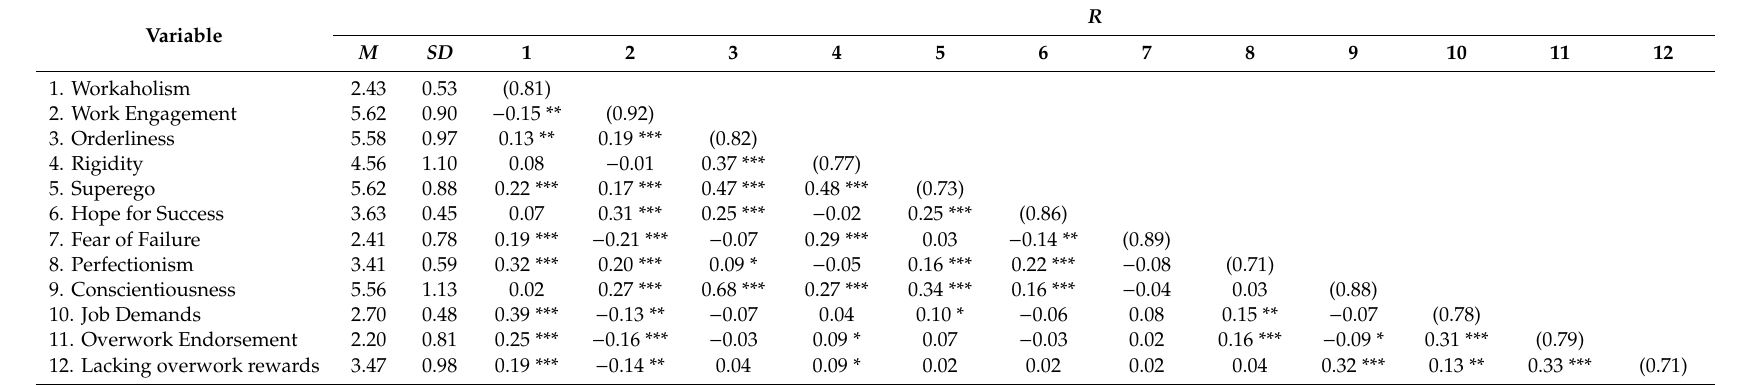
Table 1. Means ( M ), standard deviations ( SD ), internal consistency estimate (in parentheses), and correlations among the study variables ( n = 523).